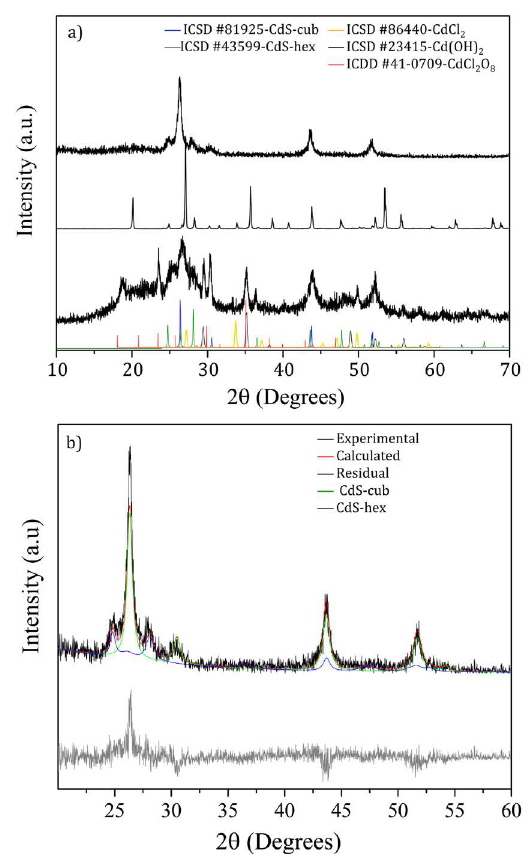
Figure 2. a) X-ray diffraction spectra of the products obtained after both of extraction processes. The spectrum of commercial CdS powder is also shown. b) Rietveld refinement of